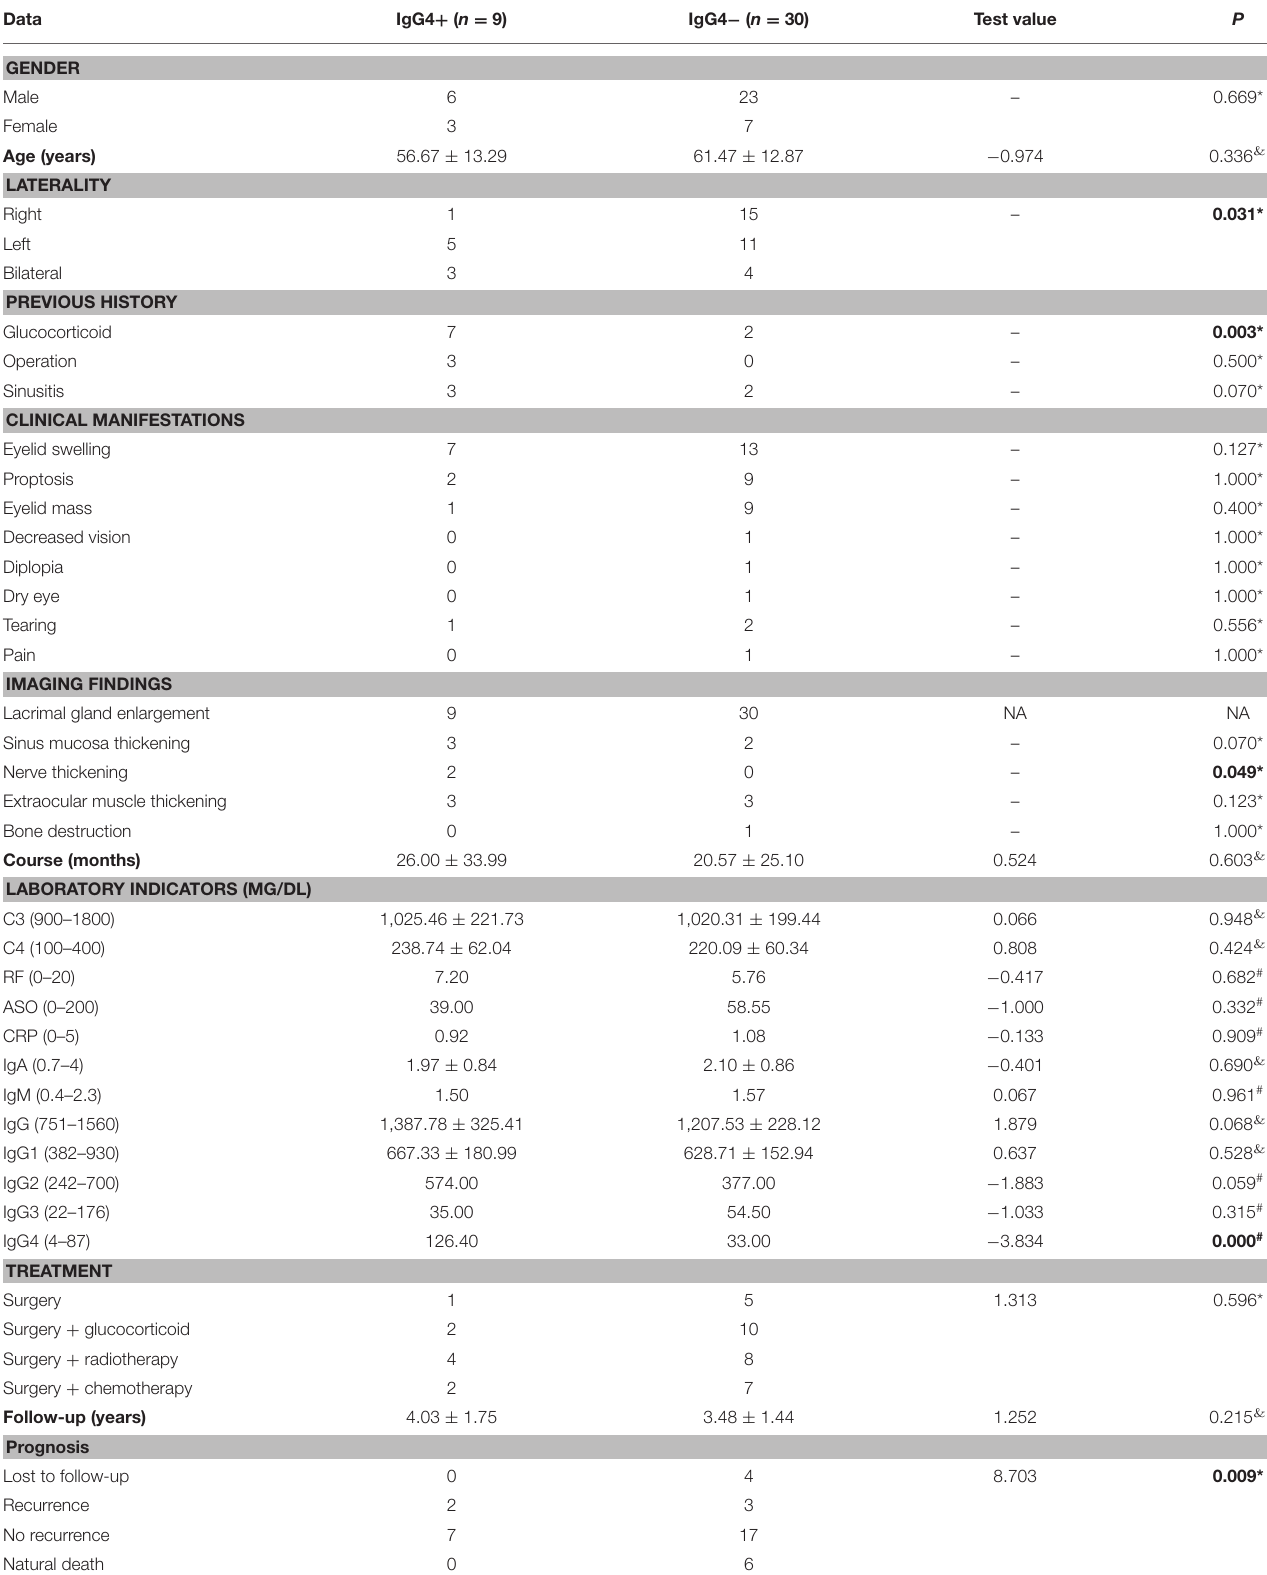
TABLE 1 | Clinical characteristics of the IgG4 + and IgG4 − lacrimal